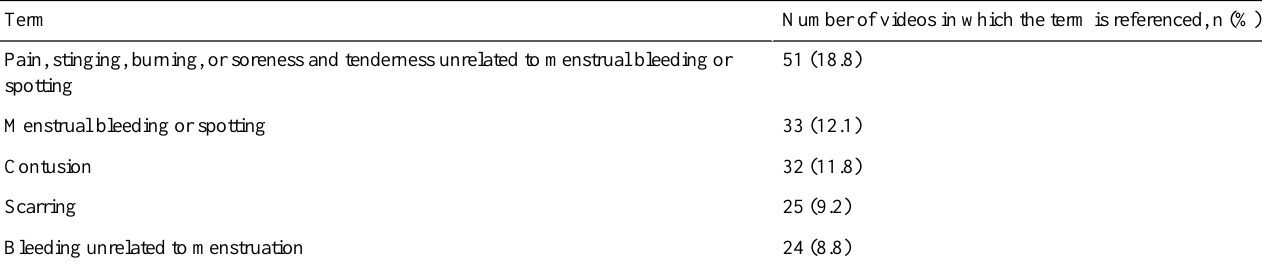
Table 1. Most frequently reported terms related to undesired implanted medication delivery device effects and the number of videos in which they are mentioned (stage 1; N=272